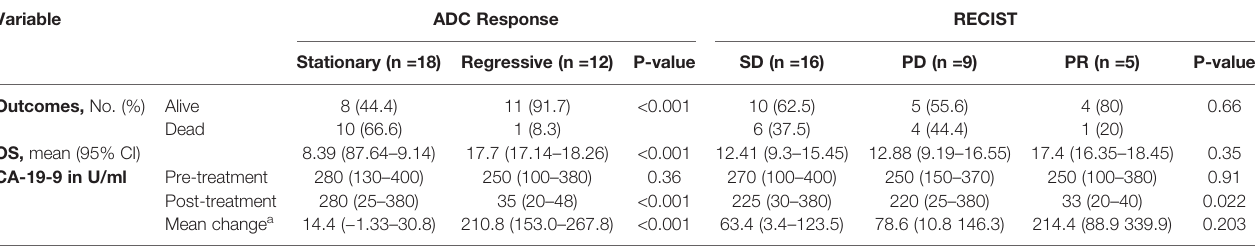
TABLE 6 | Association between ADC response/RECIST and OS of the study population and CA19-9 (n =30).